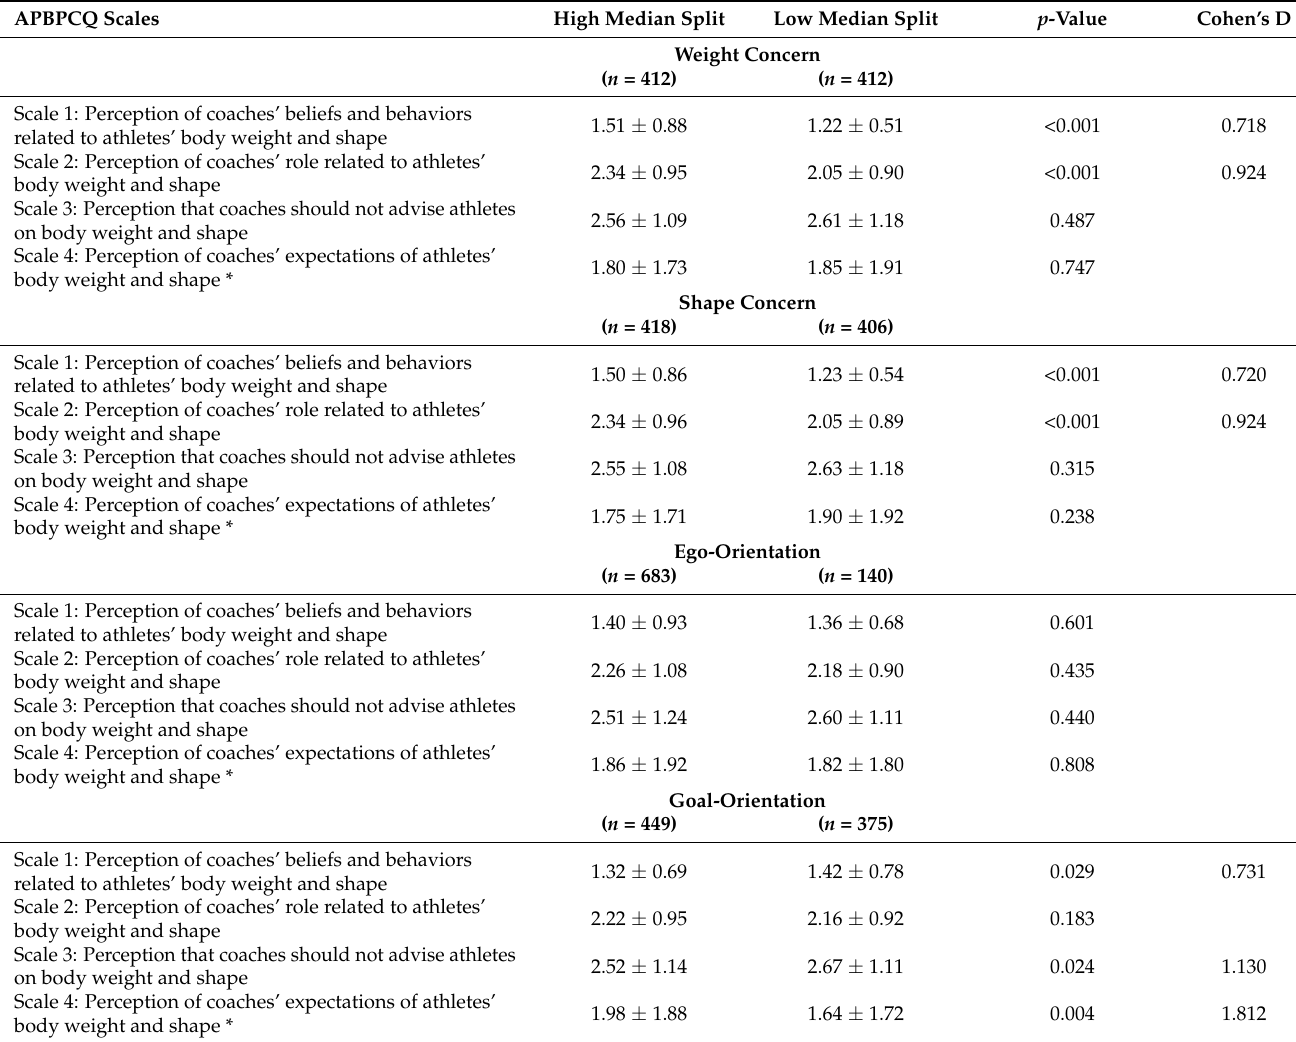
Table 6. Comparison of Athletes’ Perceived Body Pressures from Coaches Questionnaire (APBPCQ) by Weight Concern, Shape Concern, and Achievement Orientation in Females ( n = 824).